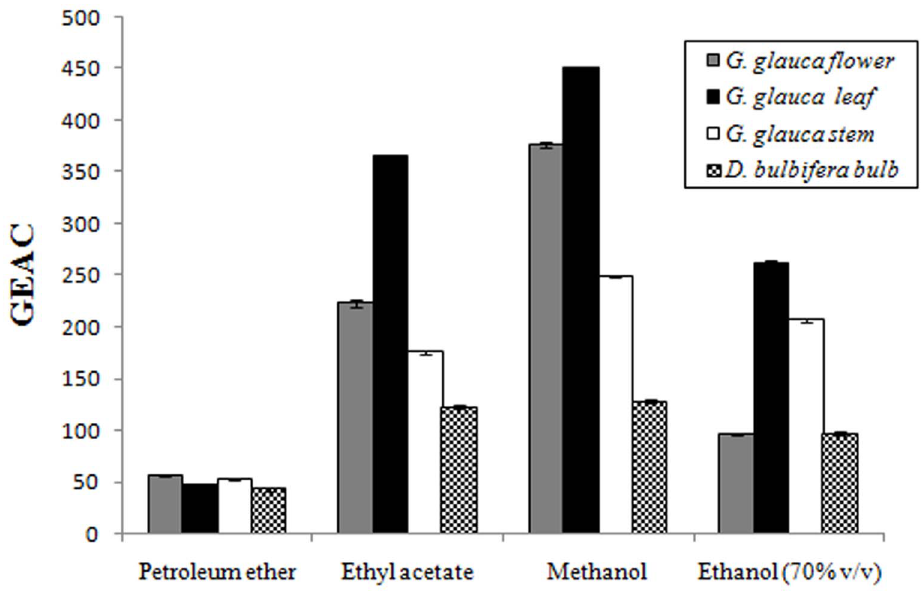
Figure 4. Ferric reducing antioxidant power of plant extracts.